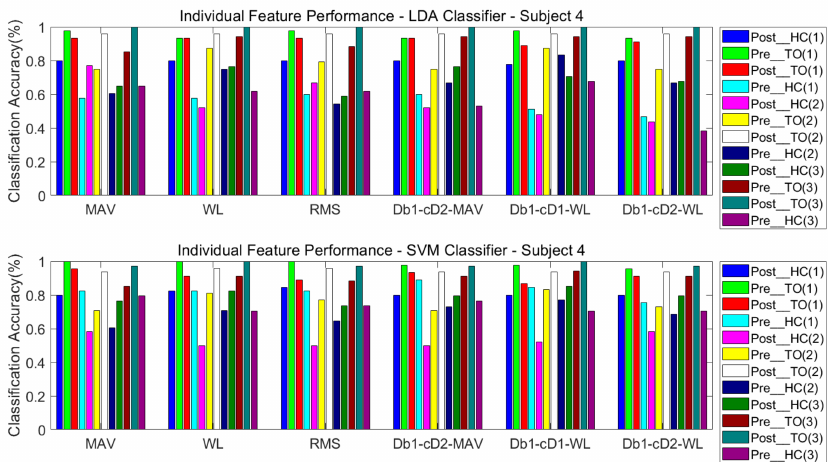
Figure 11. Classification performance of individual sEMG features; Subject